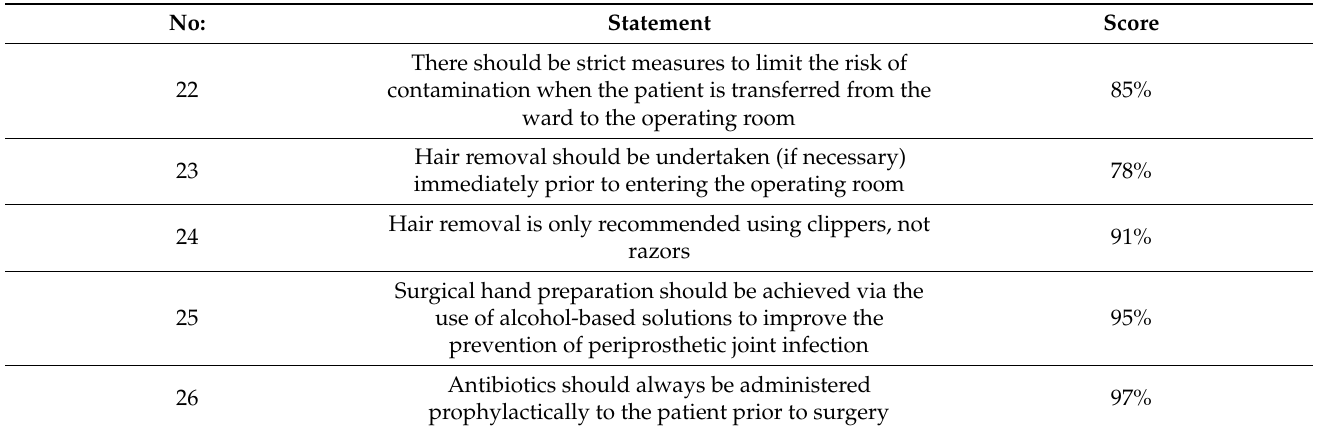
Table 3. Consensus statements and agreement scores on Domain C: role of various options available to improve the pre-operative prevention of